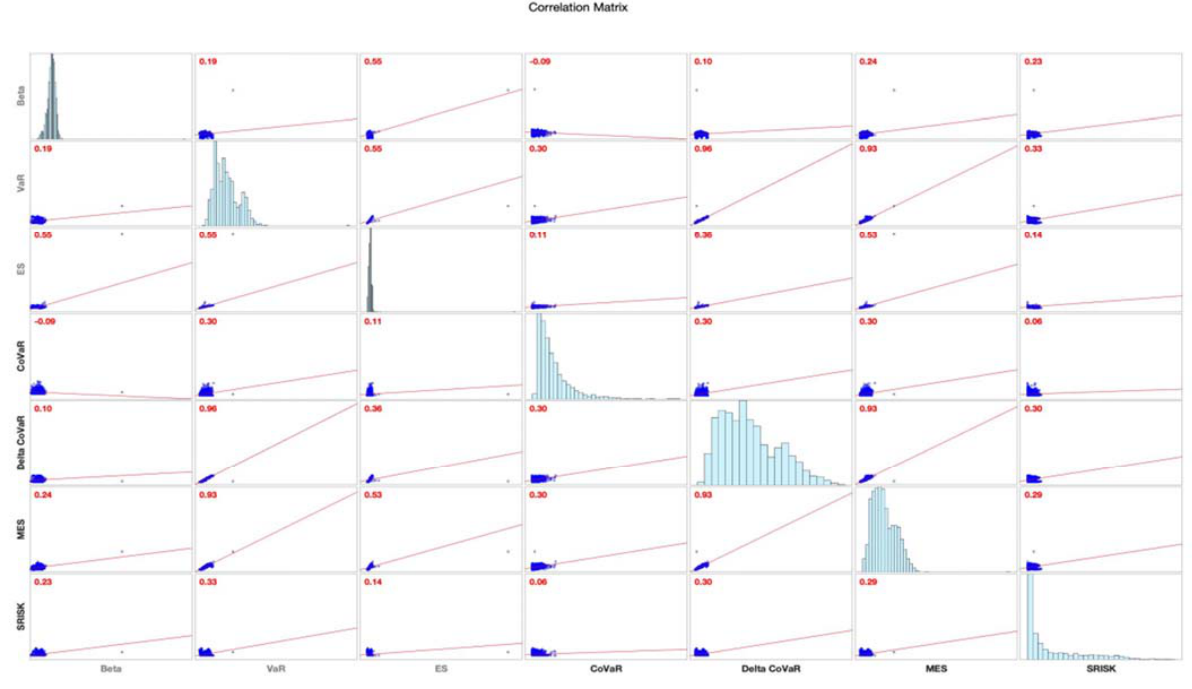
Figure 1. Correlation matrix all models.